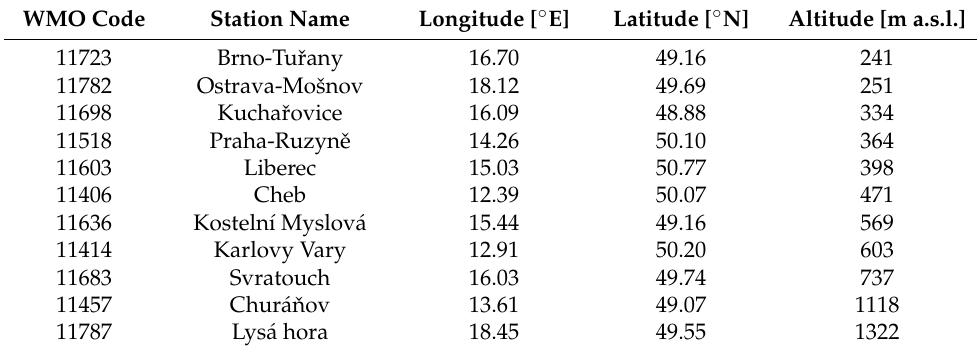
Figure 1. Orography of the ERA-Interim grid boxes and locations of stations with their altitudes (black dots are mountain stations with altitude above 1000 m a.s.l.). Table 1. SYNOP stations used in the